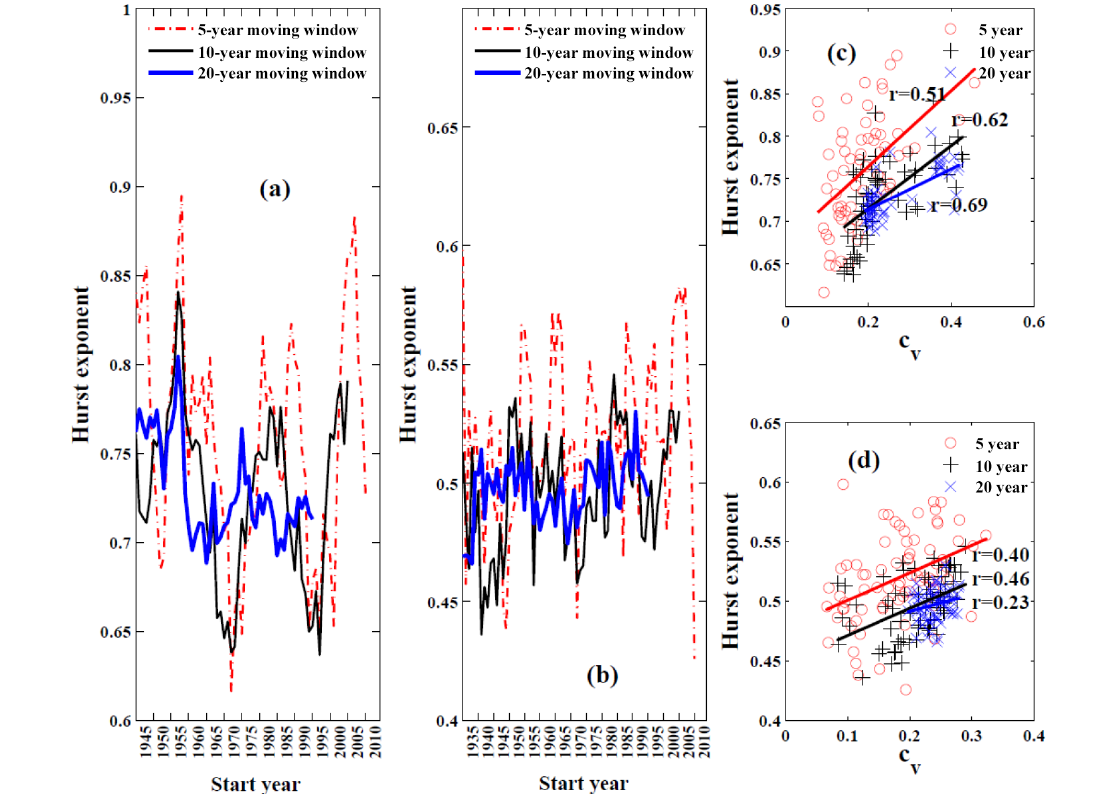
Figure 5. (a) The Hurst exponent of Well 1 groundwater levels estimated by DFA within different time windows. (b) The Hurst exponent of Well 2 groundwater levels estimated by DFA within different time windows. (c) The relationship between the coefficient of variation and the Hurst exponent obtained in panel (a) . (d) The relationship between the coefficient of variation and the Hurst exponent obtained in panel (b) .